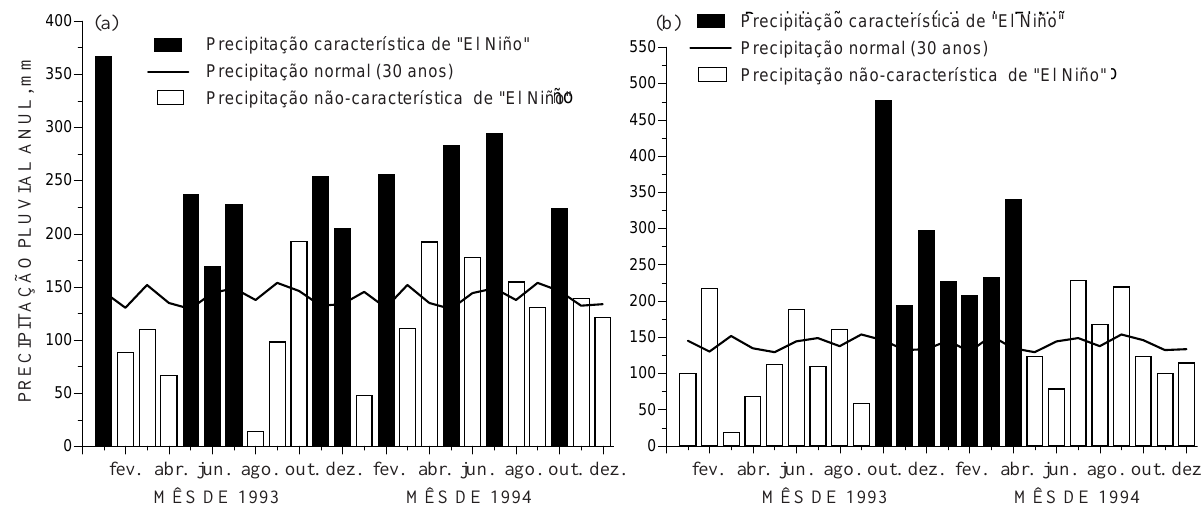
Figura 2. Distribuição da precipitação pluvial mensal durante o fenômeno “El Niño” de 1993/1994 (a) e 1997/1998 (b) e precipitação pluvial normal (média de 30 anos).